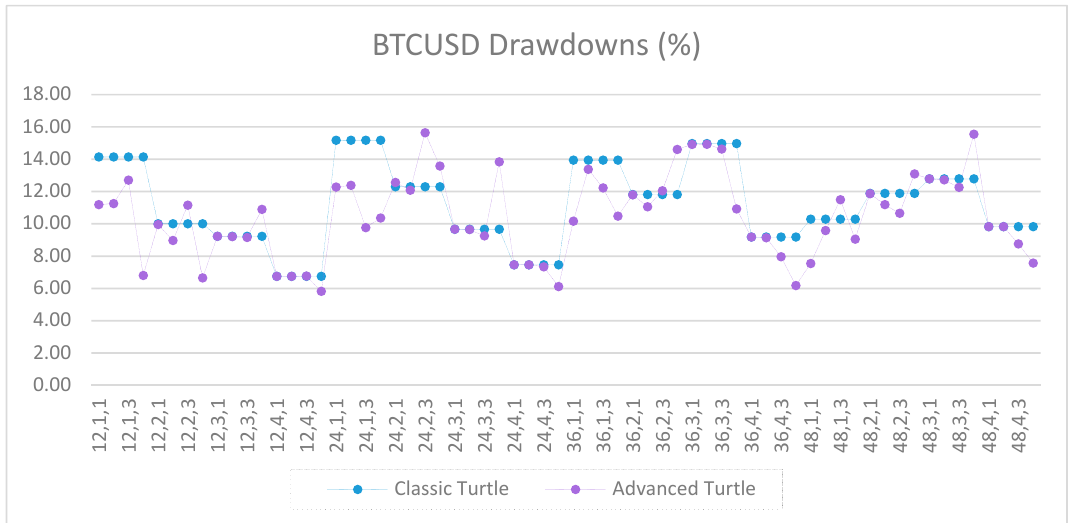
Figure A47. Net profits of BTCUSD between the classic and the advanced Turtle systems for every combination of N, X, Y for the slow parameters (80, 160).